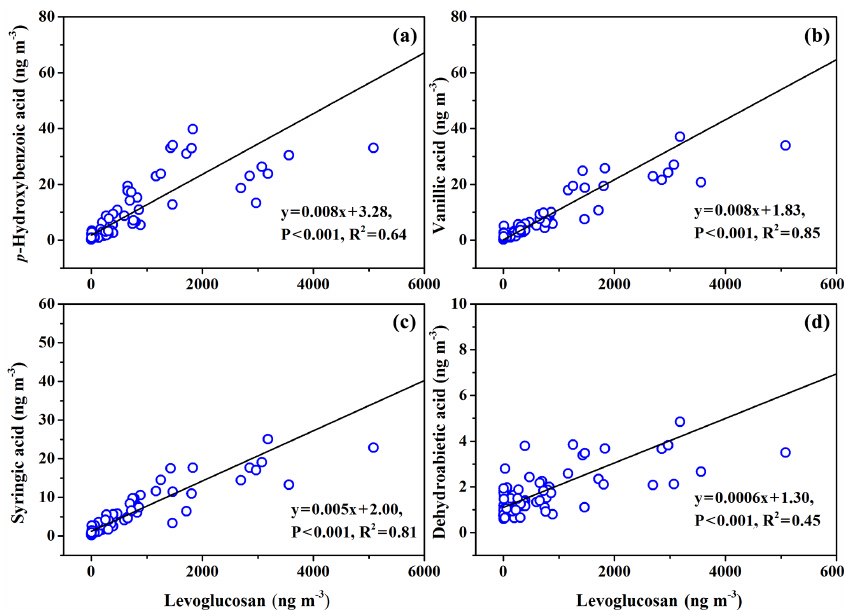
Figure 7. Correlations between (a) levoglucosan and p -hydroxybenzoic acid, (b) levoglucosan and vanillic acid, (c) levoglucosan and syringic acid, and (d) levoglucosan and dehydroabietic acid in the Lumbini aerosols during the whole